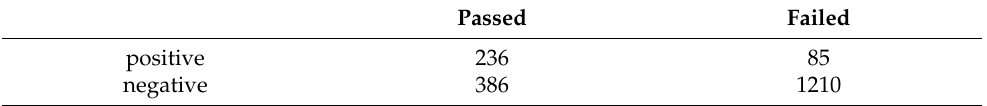
Table 6. Confusion matrix based on QEPPI scores with a threshold value of